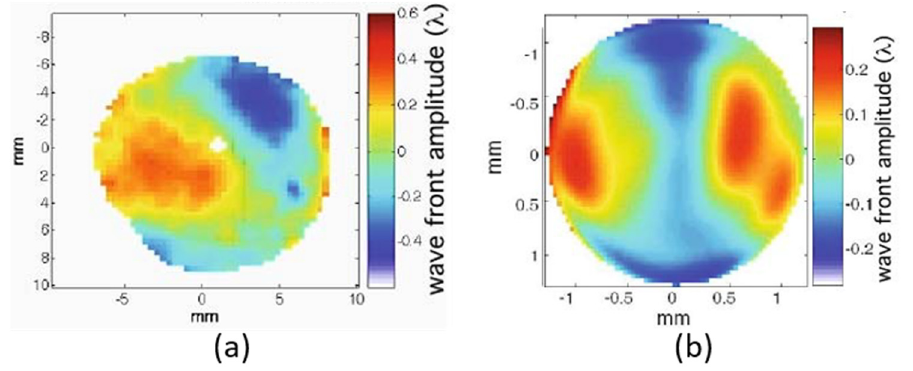
Figure 7. Wavefront maps in false color of ( a ) the High Harmonic Generation and ( b ) the infrared driving laser.